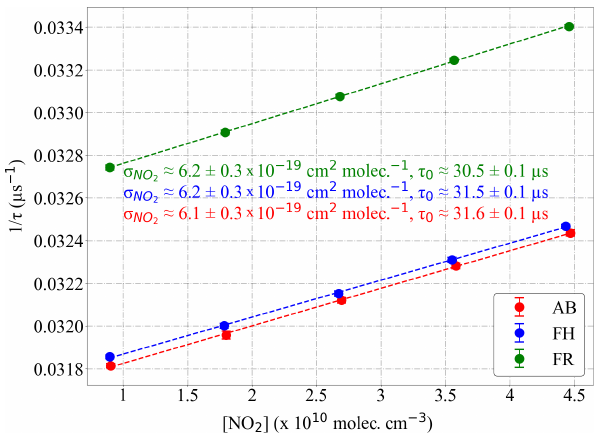
Figure 16. Experimental eCL determination of the DUALER II (a) reactor 1 and (b) reactor 2 from a series of six calibrations with generated mixing ratios of HO 2 (blue) and a (1 : 1) HO 2 : CH 3 O 2 radical mixture (red) at 200mbar inlet pressure, 300mbar (cid:49)P and NO 30ppmv within the